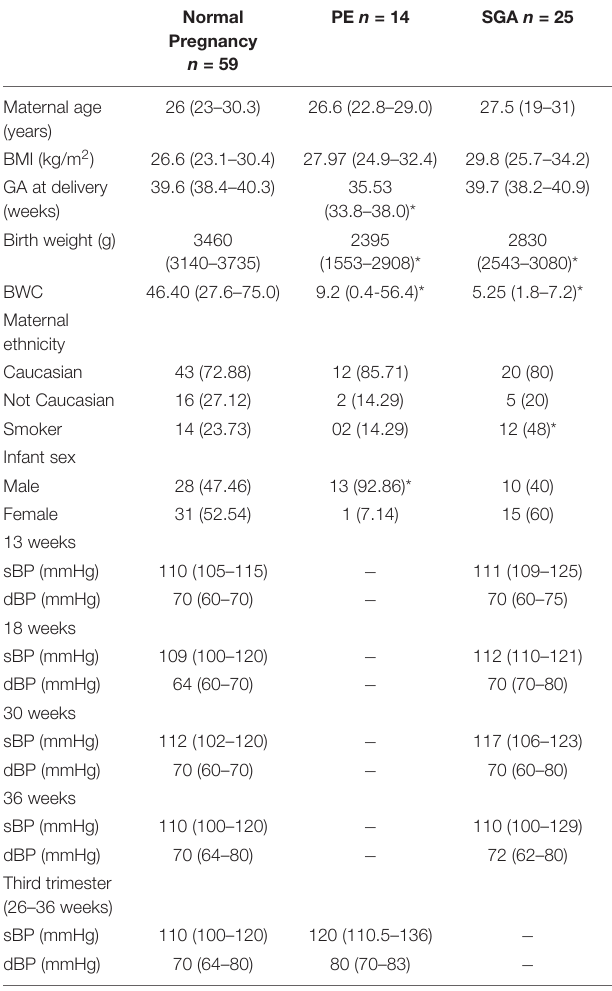
TABLE 1 | Baseline characteristics of normal, PE and SGA